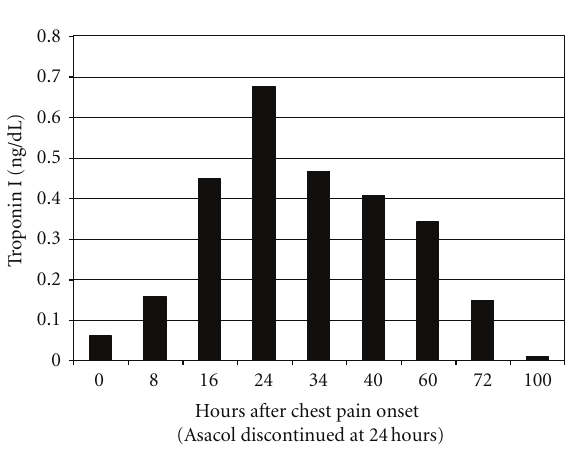
Figure 3: Cardiac enzymes trend on and o ff